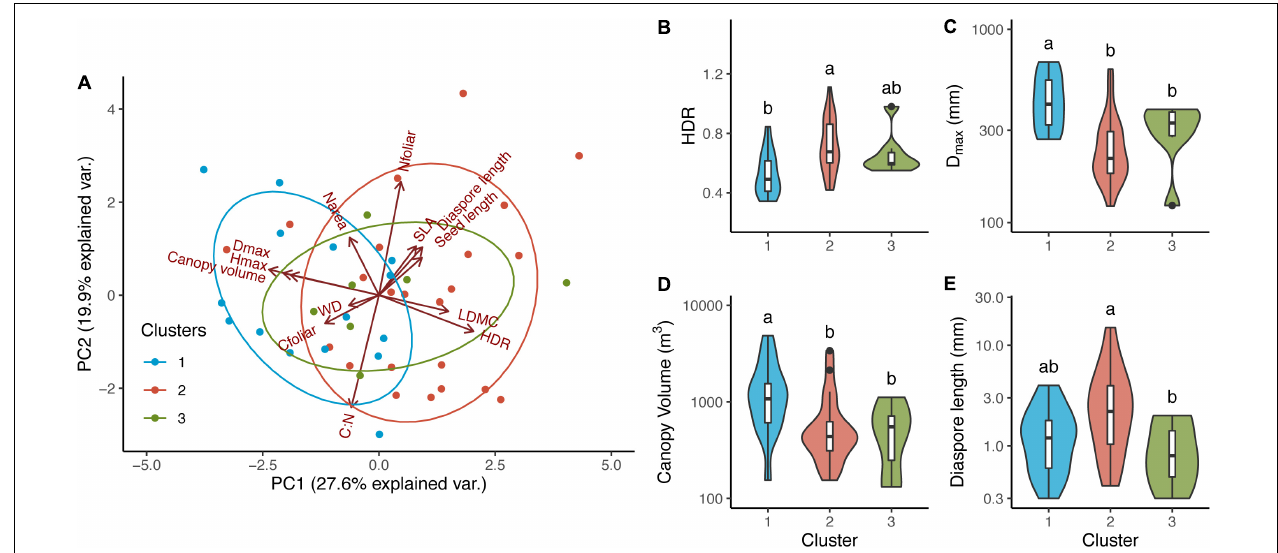
FIGURE 2 | Principal component (PC1 and PC2) analysis of 13 plant traits (A) and direct comparison between groups and traits (B–E) . Principal component scores calculated per species (45 species) classified into three different groups identified using model-based cluster analysis for growth parameters: Cluster 1 (15 species, blue circles); Cluster 2 (23 species, red circles) and Cluster 3 (7 species, green circles). Boxplots showing median, 25 ◦ e 75 ◦ percentis. Vertical curves represent kernel densities estimates as a function of the probability density for each parameter. Variables as follow: N area , nitrogen concentration per leaf area (g m − 2 ); N area , leaf nitrogen concentration per mass (%); SLA, specific leaf area (m 2 g − 1 ); WD, wood density; Diaspore length (mm); Seed length (mm); LDMC, leaf dry matter content (g g − 1 ); C:N, leaf C to N ratio; C foliar , leaf C concentration (%), H max , maximum species height (m); D max , maximum species diameter (cm); HDR, height to diameter ratio; Canopy volume (m 3 ).